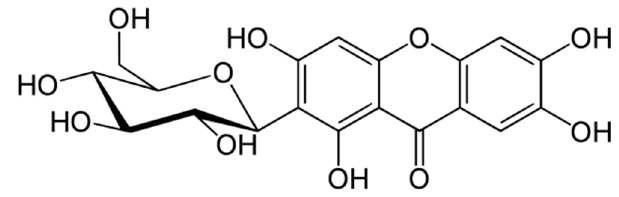
Figure 1. Molecular structure of mangiferin.